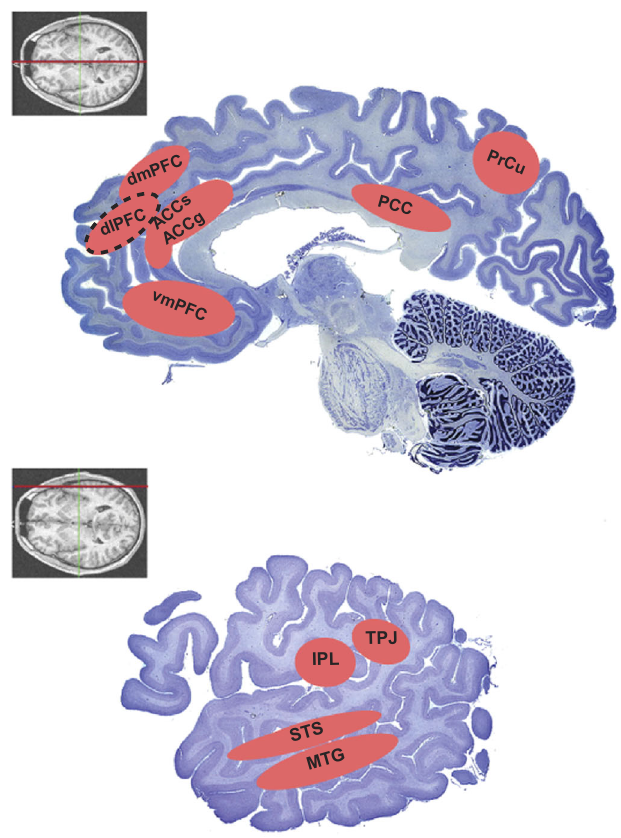
Fig. 1 Key brain regions involved in representing information with respect to another individual. These areas are often implicated in mentalizing, detecting the beliefs of others, or signaling decision variables concerning another individual. See texts for how these areas are implicated in representing information with respect to another individual. The insets with coronal magnetic resonance images indicate the sections ( red line ) that correspond to the Nissl- stained sagittal slices. The dotted outline around an area indicates that this area is projected medially from the lateral surface for the purpose of including the area on a more medial aspect of the brain. Adapted with permission from http://www.brains.rad.msu.edu, http://brainmuseum.org, supported by the US National